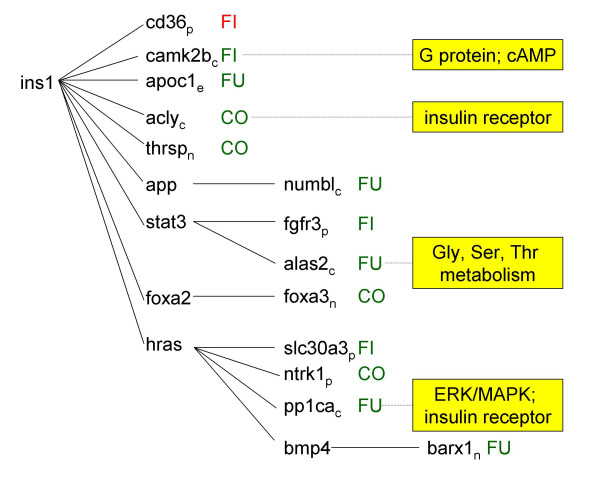
Pathway analysis. Figures 3-7 represent signaling pathways for 58 focus genes selected from Table 3 by Ingenuity Systems software (Redwood City, CA. The following signaling cascades are shown: JUN, TNF, and CDKN2A signaling cascade affecting: DNA replication; recombination and repair; immune response; and cell cycle (Fig. 3); TGFB1 signaling cascade affecting: cell morphology; cancer; and tumor morphology (Fig. 4); CTNB1 signaling cascade affecting: cell signaling; gene expression; and cell cycle (Fig. 5); INS1/hRAS signaling cascade affecting: carbohydrate metabolism; endocrine disorders; and metabolic disease (Fig. 6); and MYC signaling cascade affecting: viral function; gene expression; and cell Cycle (Fig. 7). Differentiating groups (per Table 3) are overlaid onto the signaling diagrams, and abbreviated: FU, fungal; FI, fish oil; CO, combination diet. When CO was the differentiating group, absolute differences between FU and FI are indicated. Intracellular location of focus genes (subscripts) are annotated: C, cytoplasm; E, extracellular; N, nucleus; P, plasma membrane; U, unknown. Major canonical functional/signaling categories associated with genes in the figures identified by the software, are shown in yellow boxes.